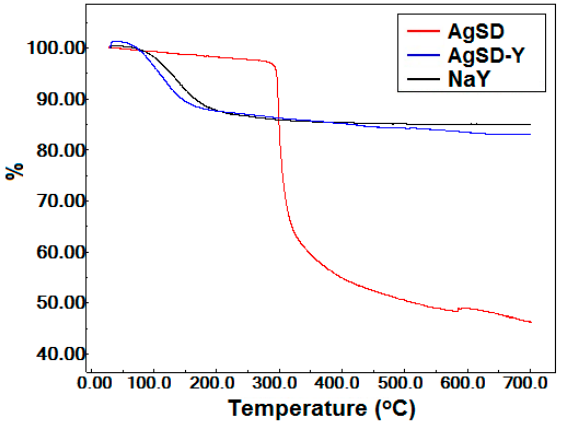
Figure 5. Curve of AgSD, AgSD-Y and NaY samples.